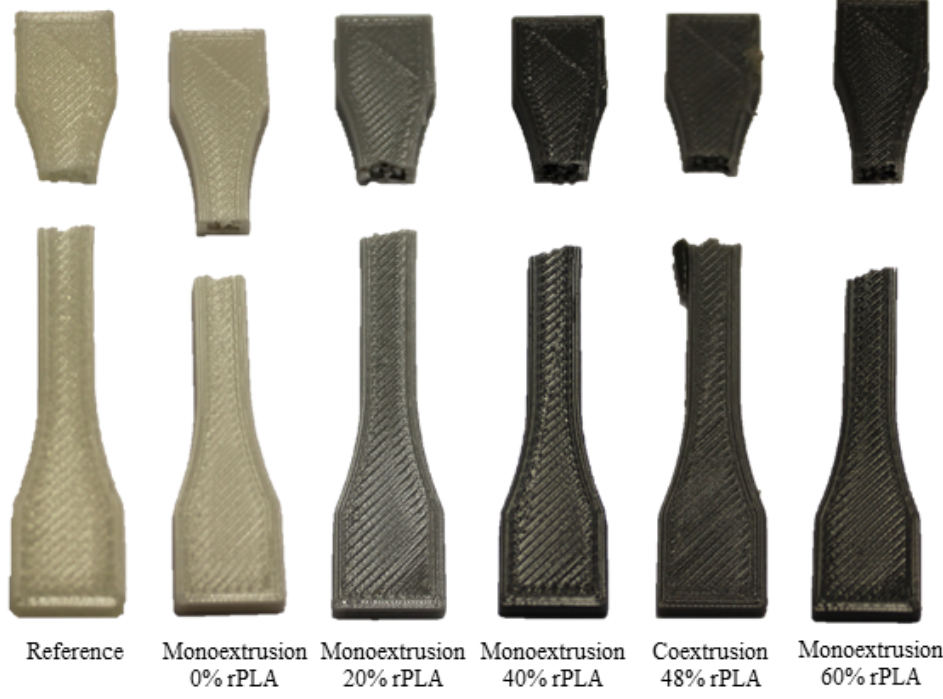
Figure 4. Tensile testing samples manufactured in horizontal